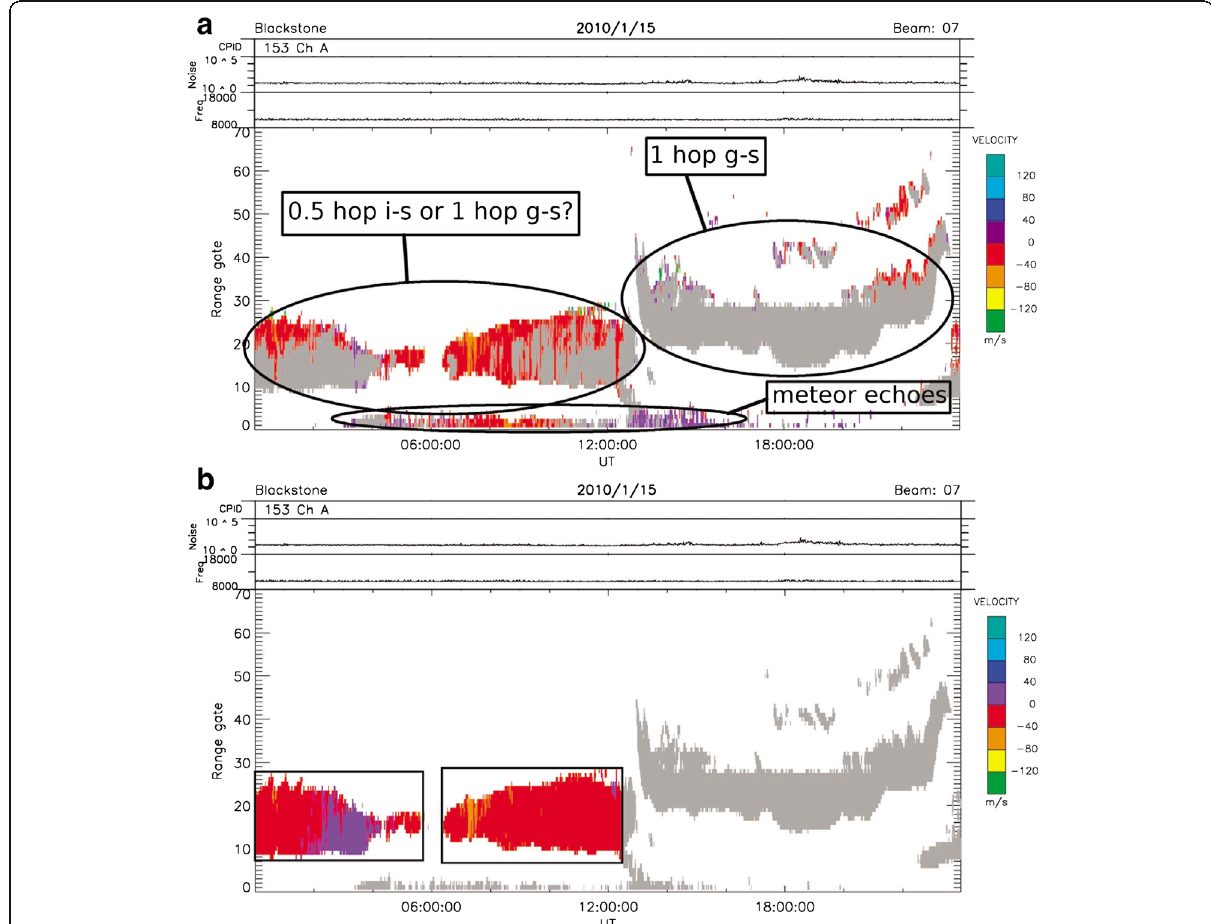
Fig. 22 Classification of LOS Doppler velocities from beam-7 of the Blackstone radar on 15 January 2010 according to a the traditional point-by- point threshold method (top) and b the new clustering method (bottom). Ionospheric scatter is colored according to the scale at right while ground scatter is shaded gray. Reproduced from Fig. 3 of Ribeiro et al.